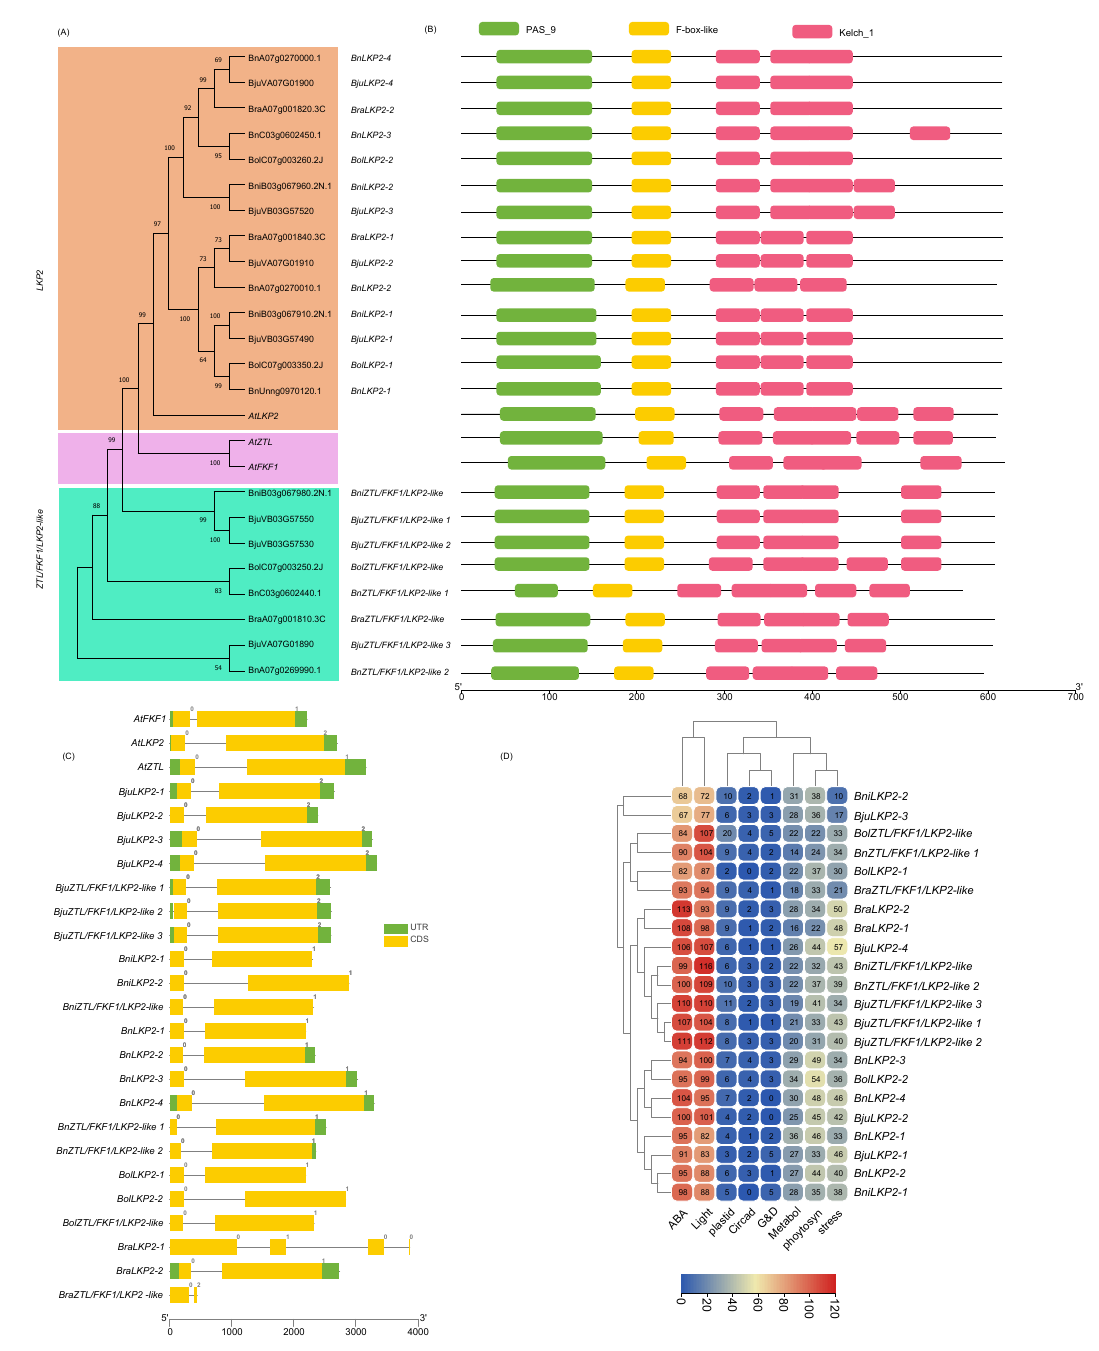
Figure 5. Phylogenetic analysis, classification, and structural description of F-box containing flavin binding protein (ZTL/FKF1/LKP2) gene family in Brassica species. ( A ) The unrooted phyloge- netic tree was established with Arabidopsis and five Brassica species ( B. rapa , B. oleracea , B. nigra , B. napus , and B. juncea ) ZTL/FKF1/LKP2 class protein sequences using the neighbor-joining tree method with 1500 bootstrap replications in MEGA11. ( B ) Represents the domain architecture of phylogenetically classified ZTL/FKF1/LKP2 genes of Brassica species, while ( C ) represents the gene structures including Intron/exon pattern and intron phases (Class 0, 1, and 2) and UTRs. ( D ) Heatmap represents the key cis-regulatory elements (ABA- and light-responsive, elements associ- ated with plastids, circadian rhythm, growth and development (G&D), stress, metabolite biosynthesis, and photosynthesis) and their abundance in putative promoter motifs of Brassica CRY genes reported in this